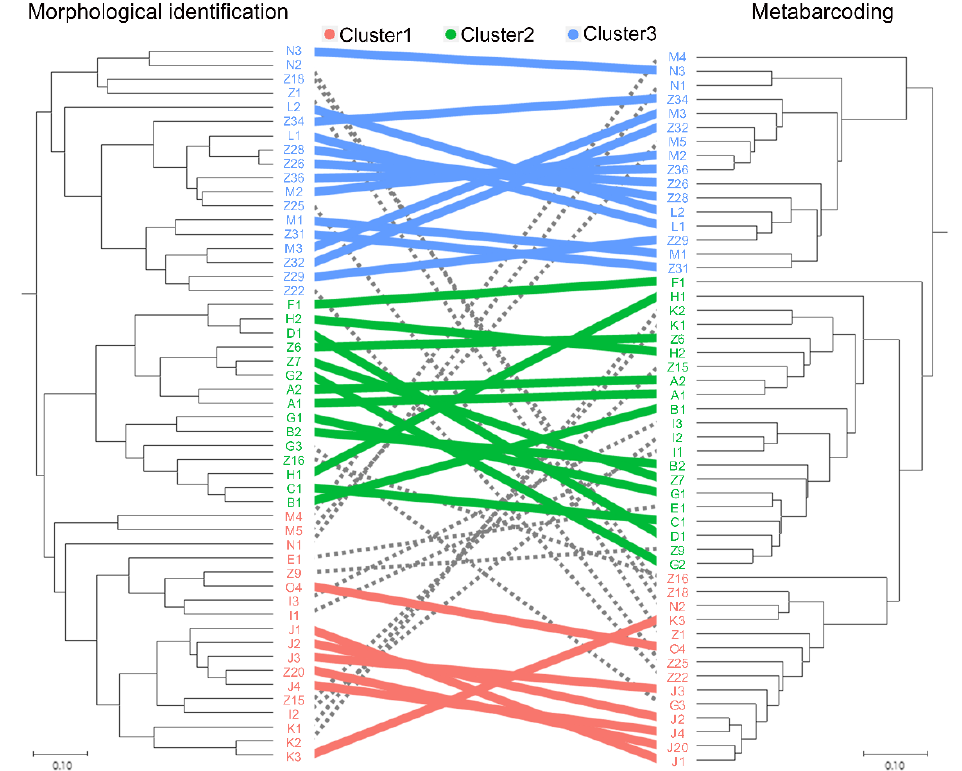
Figure 3. Comparison of unweighted pair group method with arithmetic averages (UPGMA) cluster trees for mesozooplankton communities between morphological identification and metabarcoding results using Bray–Curtis dissimilarities.